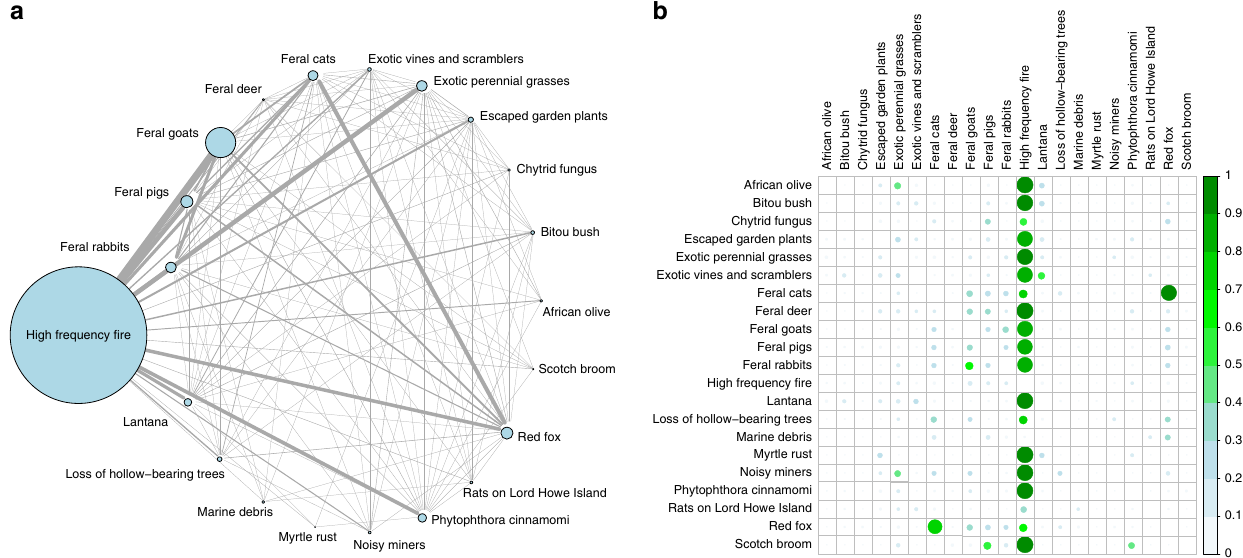
Fig. 7 Extent and frequency of interactions between key threatening processes. Panel a illustrates the number of interactions between threats. Network edge sizes are scaled to the number of species that are affected by a pair of threats; node sizes and colours are scaled to the number of species affected by the threat. Panel b illustrates the frequency of the interactions. Rows show the proportion of species affected by the threat that are also affected by the threat in each